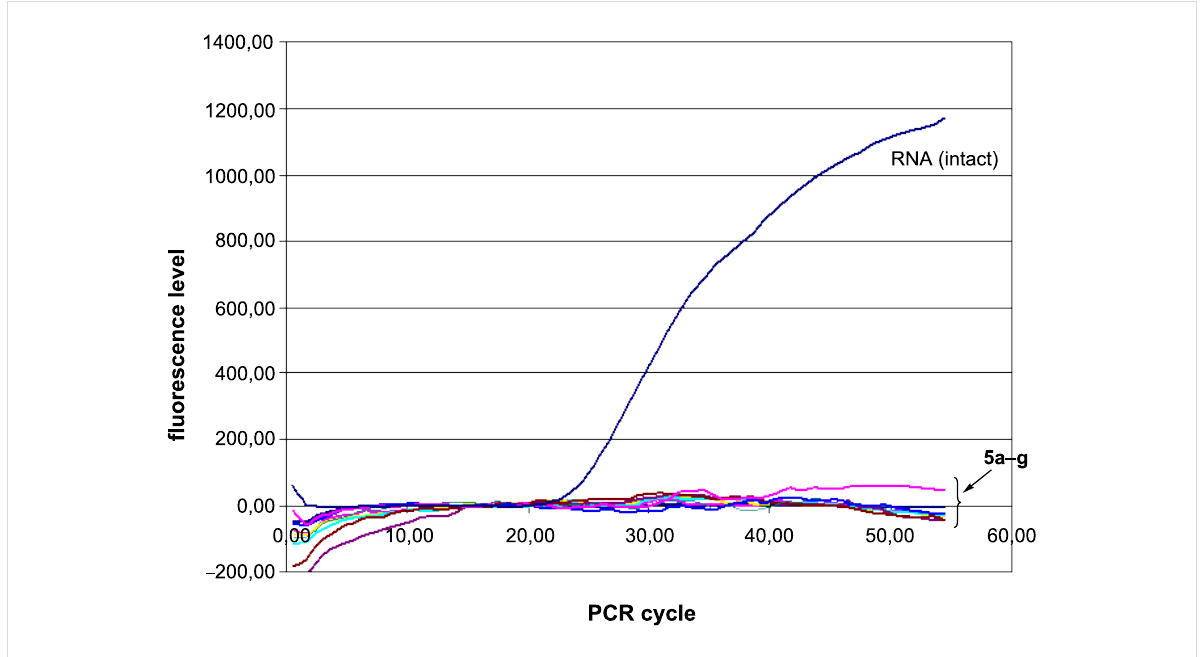
Figure 2: Results of RT-qPCR of the TBEV RNA cleavage products in presence of 2.5 mM peptidomimetics 5a–g at 37 °C for 2 hours in H 2